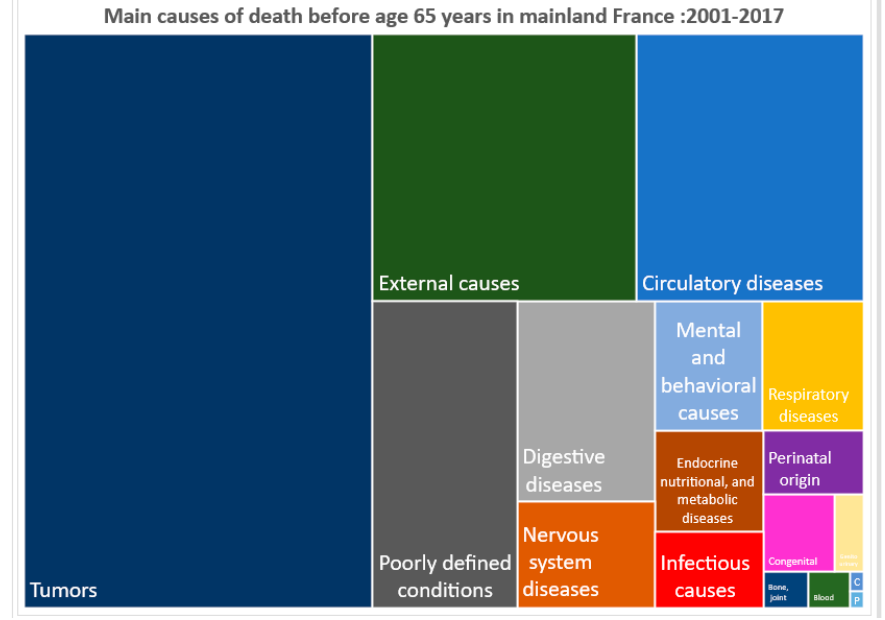
Figure 4. Treemap of the causes of premature deaths in mainland